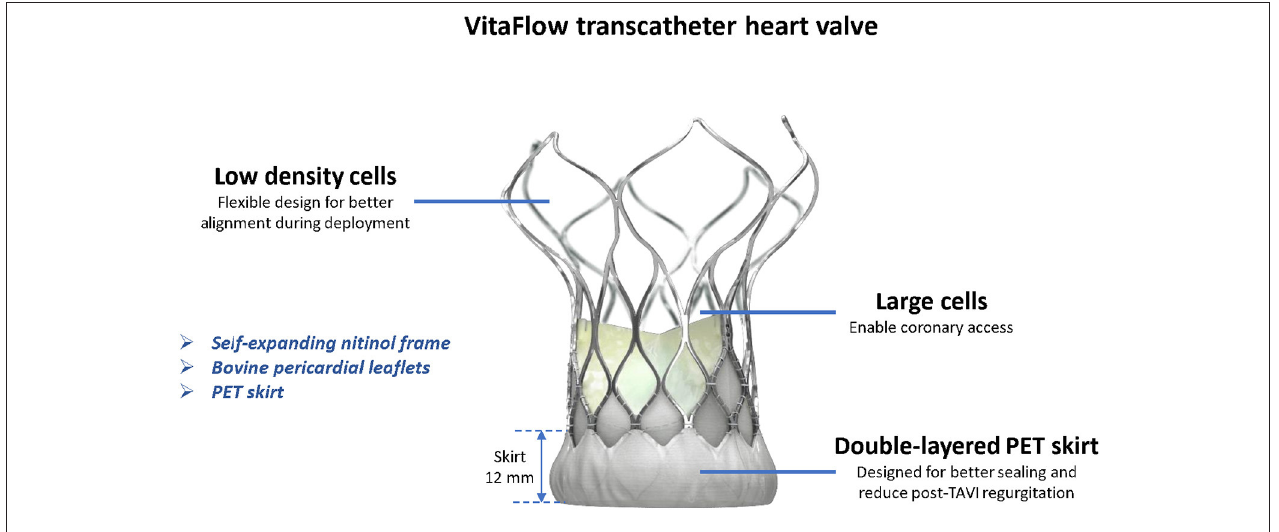
FIGURE 5 | The VitaFlow transcatheter aortic valve